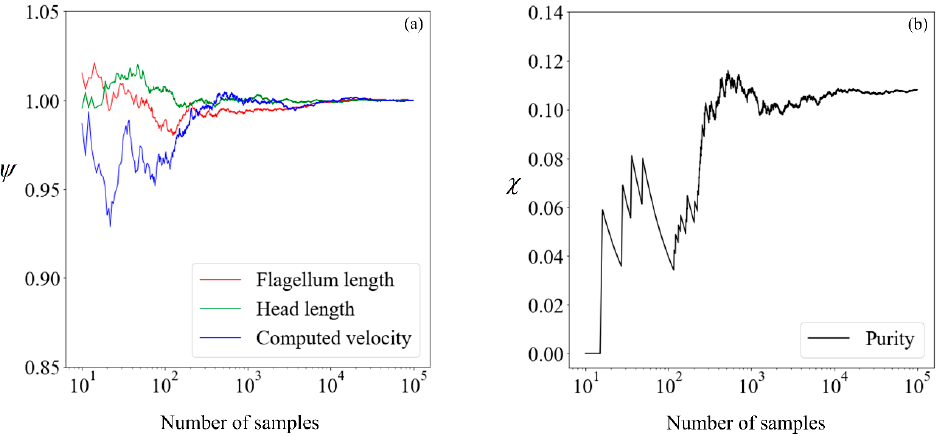
Figure 6. ( a ) Cumulative mean flagellum length (red line), head length (green line), and computed velocity (blue line) normalised with respect to mean values obtained from 100,000 samples; ( b ) proportion of morphologically normal cells in percentage points. The x -axis, in logarithmic scale, of each plot denotes the number of samples used in the computation.